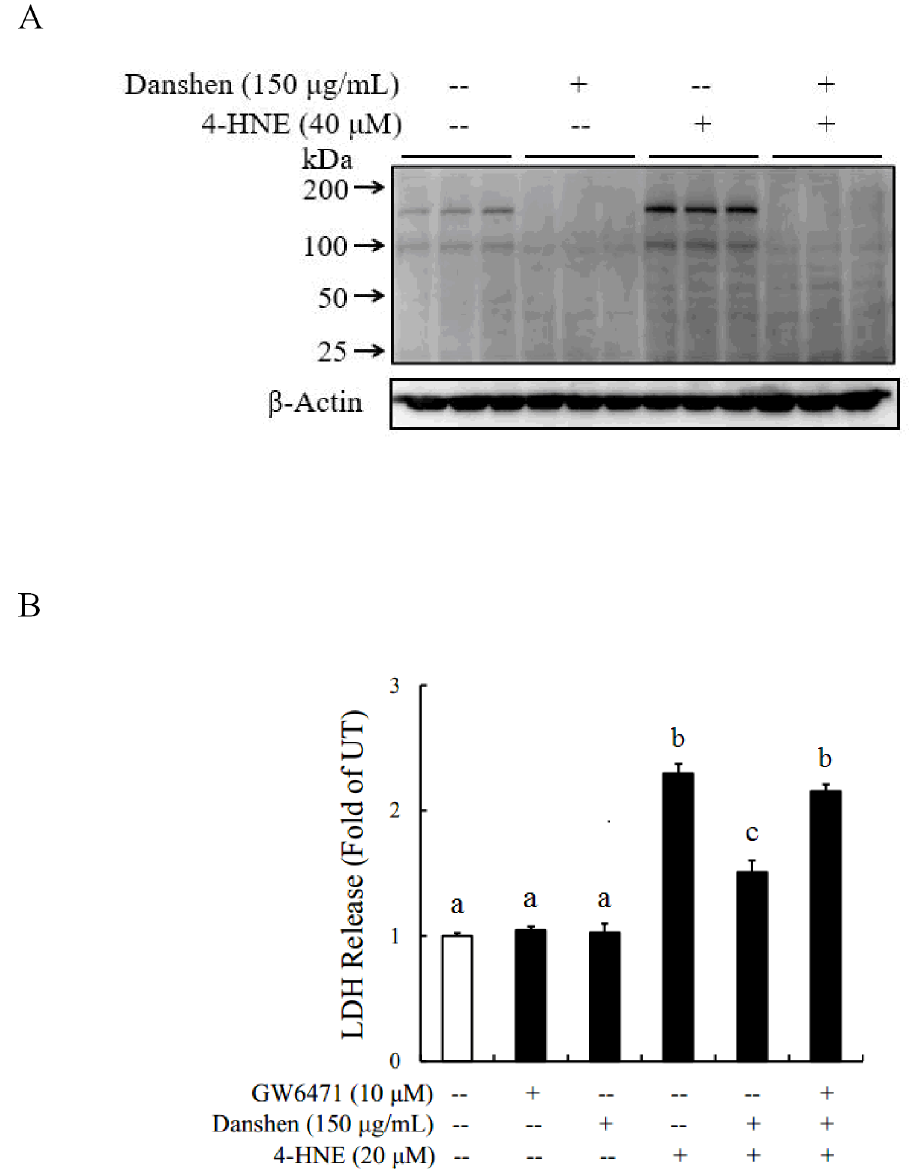
Fig 5. PPAR α activation contributes the hepatoprotective effect of Danshen against 4-HNE hepatotoxicity. A . Danshensignificantly reducesthe intracellular 4-HNE accumulation after exogenous 4-HNE exposure. NCTC1469cells are pretreatedwith 150 μ g/mLDanshen for 2 hours before 4-HNE addition. Cell lysates were collected8 hours later for Western Blotting analysis. B . GW6471, PPAR α antagonist, significantly increasedcell death inducedby 4-HNE in HepG2 cells. HepG2 cells are pretreatedwith GW6471 for 1 hour, then Danshen was treated 2 hours before 4-HNE exposure. LDH releaseis measured16 hours later. All values are denotedas the mean ± SD from three or more independentstudies. Bars with different letters differ significantly (p < 0.05).